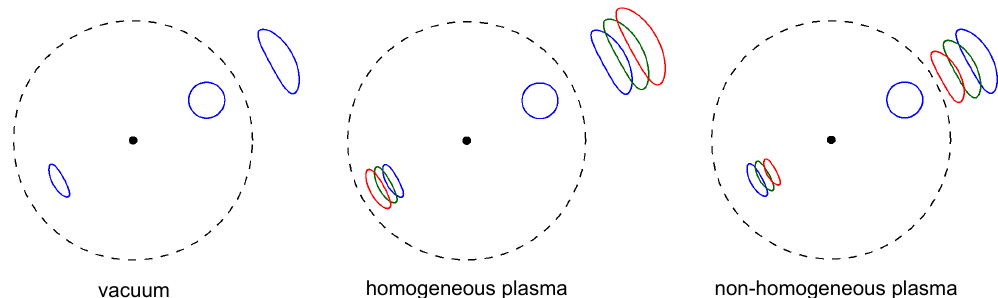
Figure 6. Comparison of lensing by point mass in vacuum ( left ) and in plasma ( middle and right ). The photon trajectories and deflection angles in vacuum don’t depend on the photon frequency (or energy). Therefore lensing in vacuum is achromatic, and the Schwarzschild point-mass lens leads to two images with complicated spectra, formed by the photons of different frequencies which undergo deflection by the same angle. If lens is surrounded by plasma, the light rays of different frequencies have different deflection angles. The images become diffused and divide into many images formed by photons of different frequencies. Difference in angular position of images of different frequencies take place both in homogeneous and non-homogeneous plasma and is a subject for observation. On the left figure we present the vacuum lensing: a blue circle is the source, a black spot is the lens, a dashed circle is the Einstein ring. In the middle we present schematic picture for the situation when lens is surrounded by homogeneous plasma, see Section 2.2. Now blue color is used for images with formally infinite photon frequency (for optical frequencies the effect of plasma presence is negligible so for these frequencies it corresponds to vacuum case). Photons of lower frequencies (green and red colors) undergo plasma influence and their deflection angles becomes larger. Therefore green and red images are further from the center of the picture. Angular separation between two images of the same color becomes larger with decrease of the wave frequency (or increase of the wavelength). On the right picture we present the situation when the lens is surrounded by non-homogeneous plasma, and refraction effects prevail over effects of additional gravitational deflection due to plasma, see Section 2.3. Now plasma presence leads to decrease of the total deflection, therefore green and red images are located closer to the center of the picture. Angular separation between two images of the same color becomes smaller with decrease of the photon frequency. This case might be observed by modern facilities. Note that in these pictures we assume that the number and structure of the images do not change drastically due to the presence of plasma. In these pictures we also assume that the emission regions of the source in different bands coincide, which may not necessarily be the case in